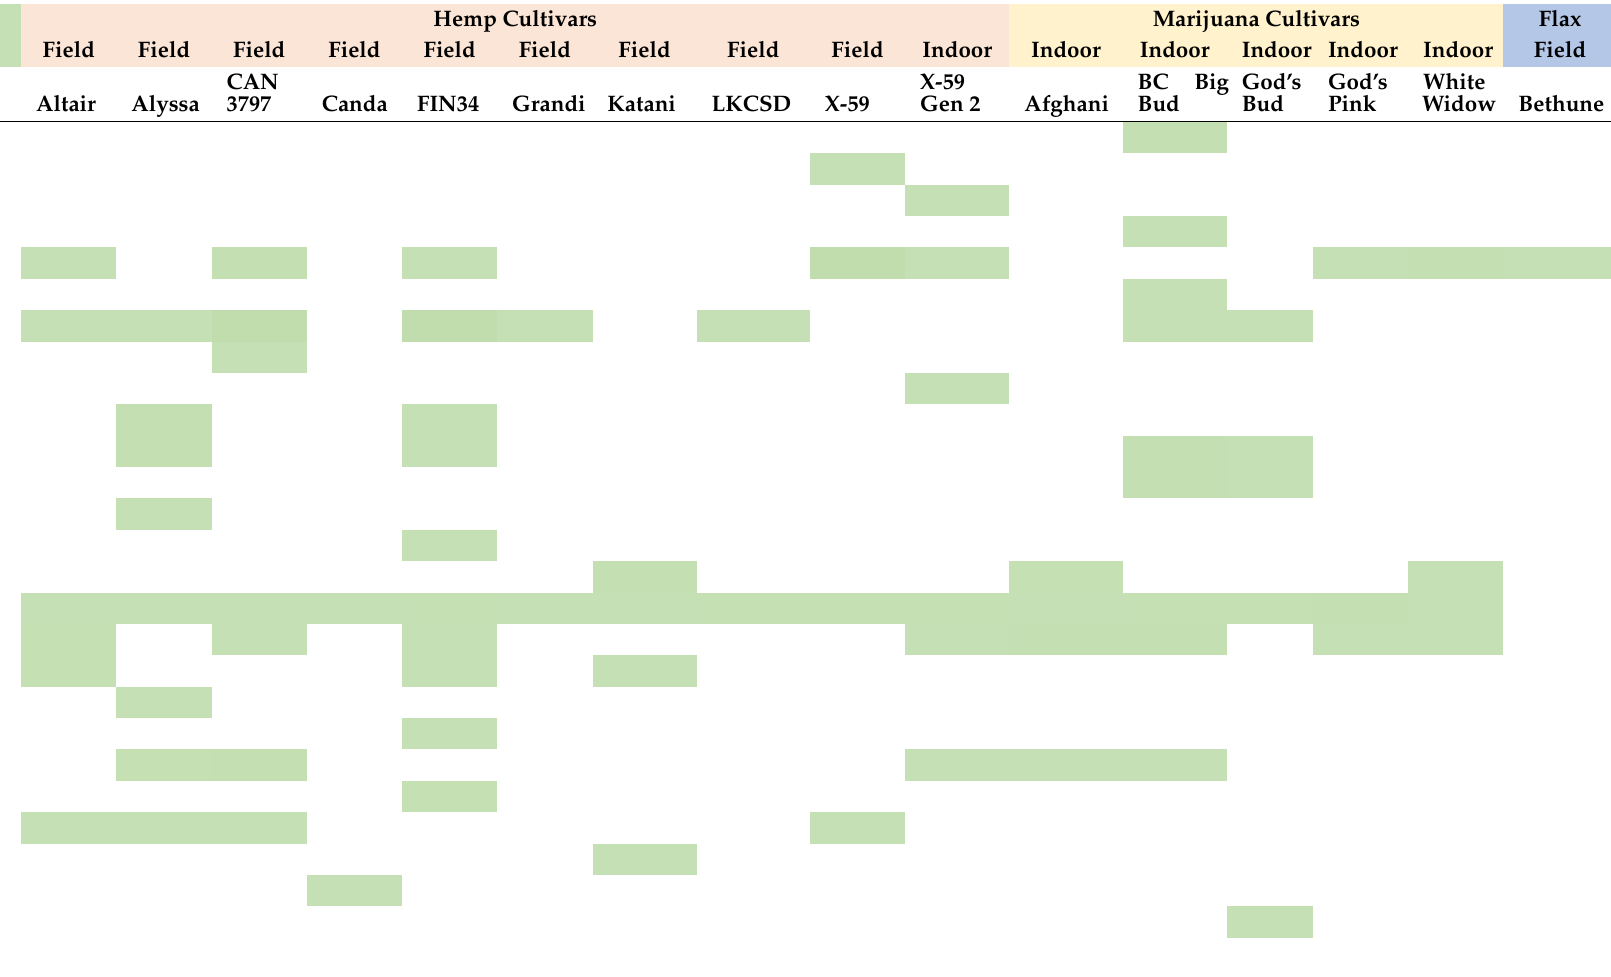
Table 1. Culturable Seed-borne Endophytes from Seedling Endospheres. Green shaded cells indicate isolation from pool of 5 seedlings following germination in sterile environment and surface